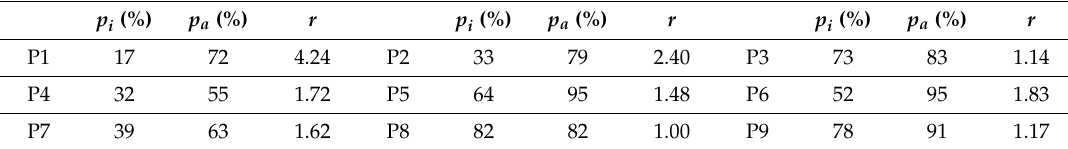
Table 2. The percent of crystalline phases in each sample ( p i —as-deposited; p a —annealed) and the ratio ( r = p a / p i ).